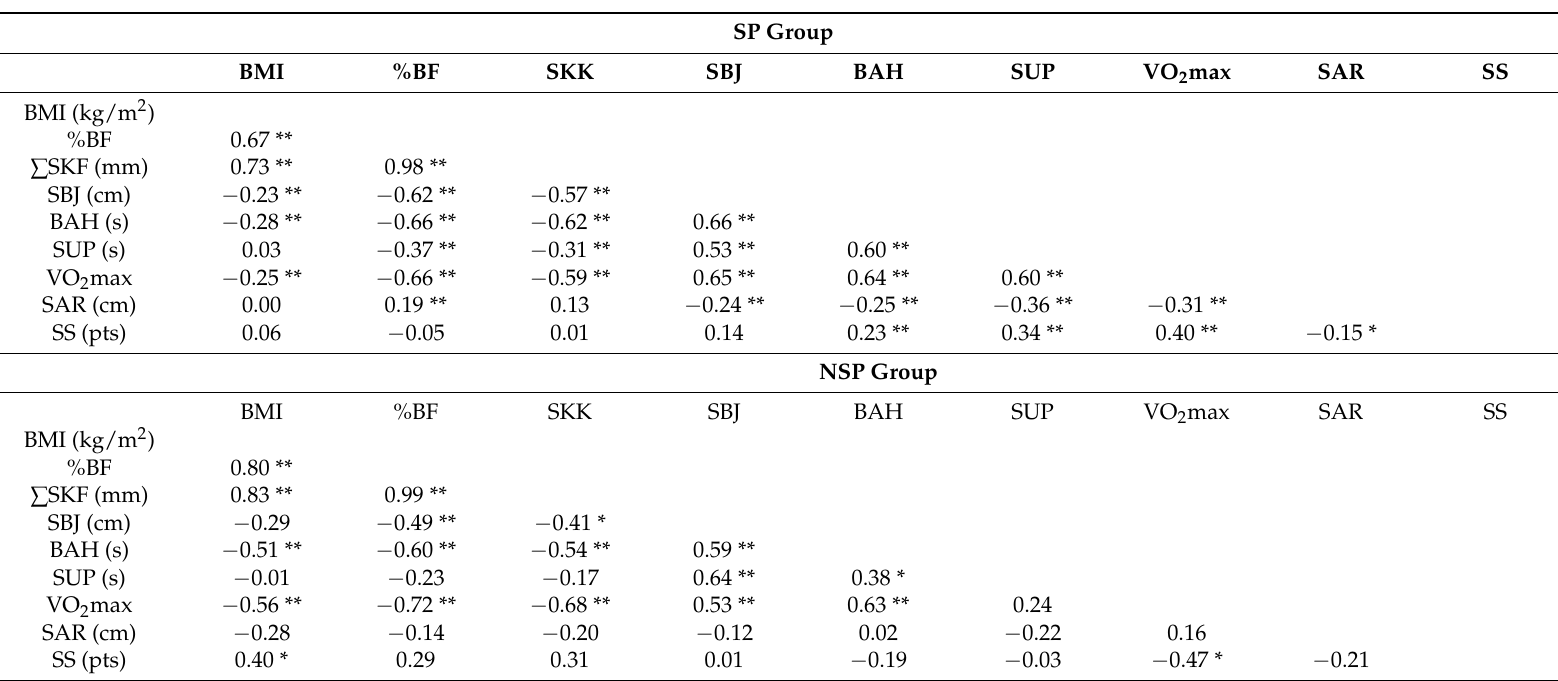
Table 3. Spearman’s correlation coefficient ( r ) between body composition, physical fitness, and social correlates for sport participation and non-sport participation groups. SP Group BMI %BF SKK SBJ BAH SUP VO 2 max SAR